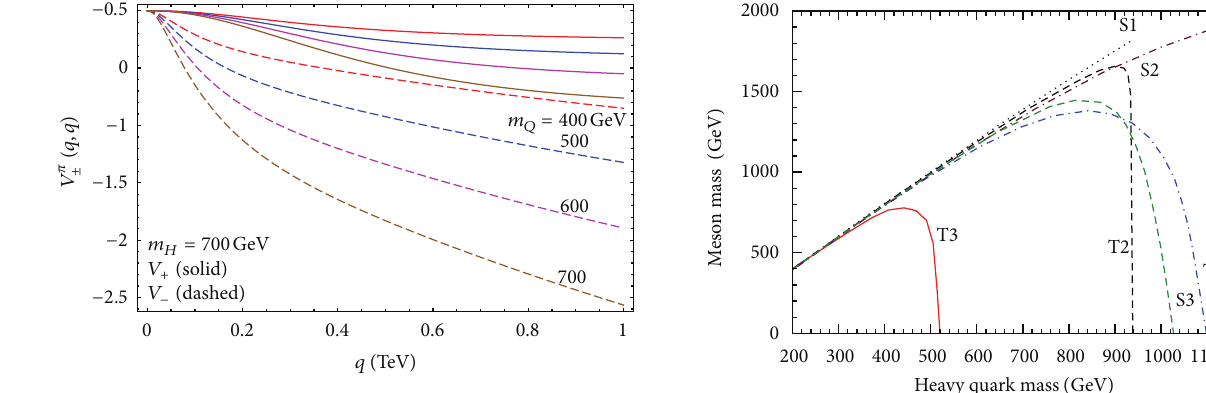
Figure 1: The 𝑉 𝜋 + (solid) and 𝑉 𝜋 − (dashed) potentials in (1) for the 𝜋 1 state, for 𝑚 𝑄 = 400, 500, 600, 700 GeV, and 𝑚 𝐻 = 700 GeV, plotted along 𝑞 󸀠 = 𝑞 . Both vanish for 𝑞 = 0 , or zero relative motion, but go to rather large values for large 𝑞 , with 𝑉 𝜋 − turning on rather sharply for 𝑞 ≳ 100 GeV.